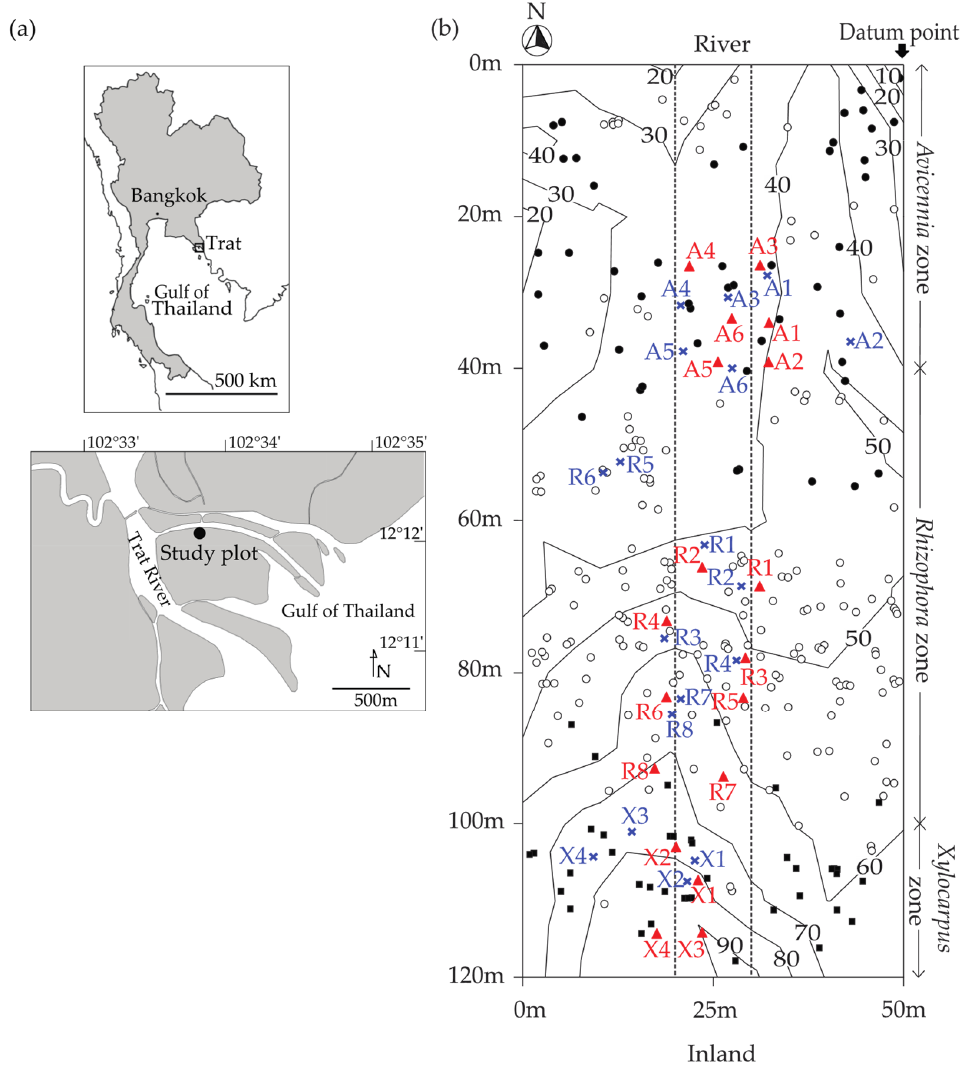
Figure 1. Trat River Estuary in eastern Thailand; ( a ) study plot location and ( b ) sampling locations in the study plot with a 10 cm contour interval and presence of trees with diameter at breast height (DBH) > 15 cm that includes Avicennia alba (closed circle symbols), Rhizophora spp. (open circle symbols), and Xylocarpus granatum (closed square symbols); dotted lines represent line transects with sampling points during the dry season (red symbols) and wet season (blue symbols).